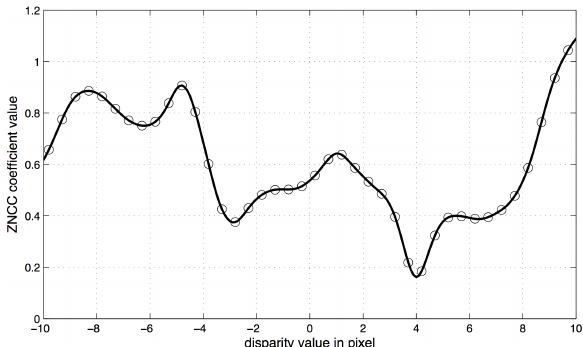
Figure 2: Illustration of the non convexity of unary terms with a 0.5 pixel discretization step to respect the Shanon sampling theo-